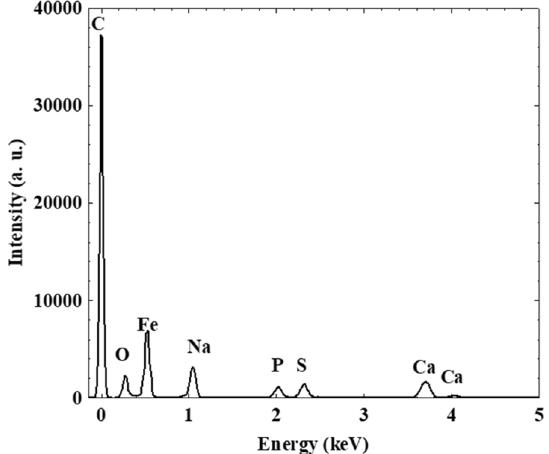
Fig. 5 EDS microanalysis of BCM2 Fig. 6 Surface charge distribution of BC and